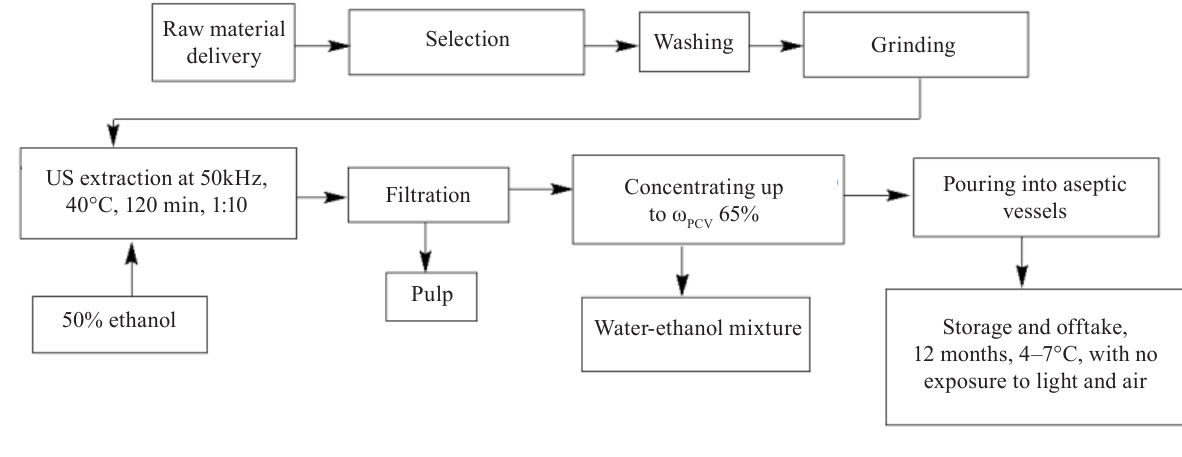
Figure 2 Procedure chart for raspberry extract